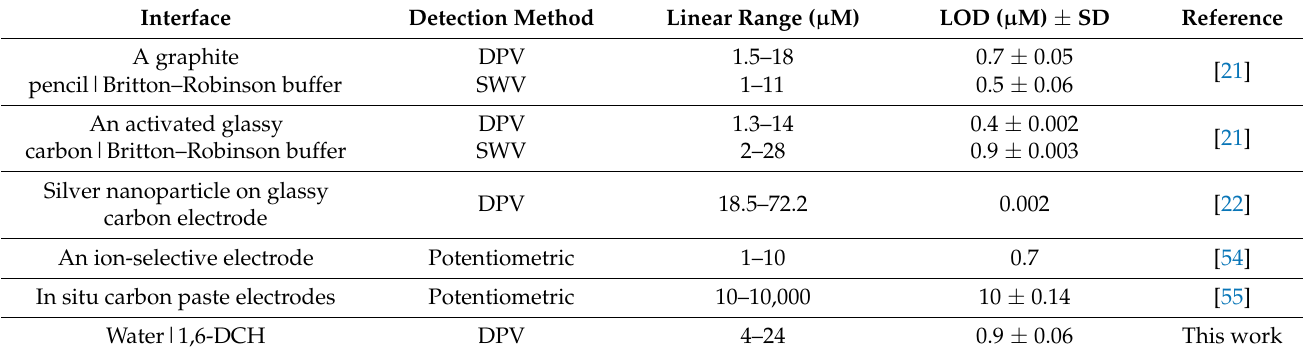
[31,40]. As indicated in the experimental section, the first solution was prepared from se- rum components, without BSA, while the second solution was prepared with BSA at physiological concentration.